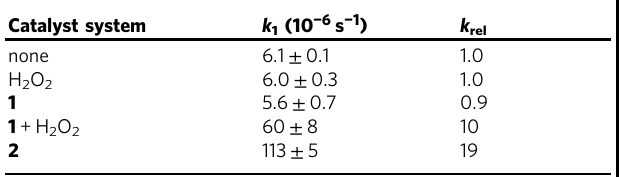
Pseudo- fi rst-order reaction rate constants ( k 1 ) for hydrazone formation were determined by followingtheabsorbanceof 5 inUV/visspectroscopy.Theerrorsarethestandarderrorofmean (the standard deviation divided by the square root of the number of